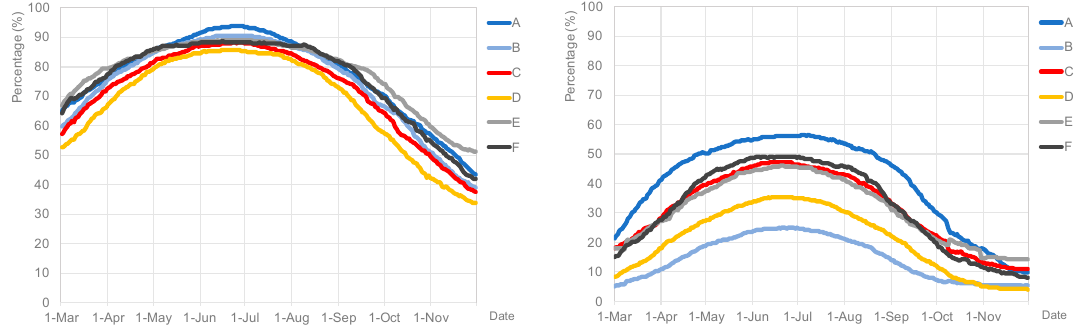
Figure 6. Percentages of ground-level surface with direct sunlight for three or more hours ( left ) and six or more hours ( right ) from March to November for study sites A to F when FAR is 1.5.